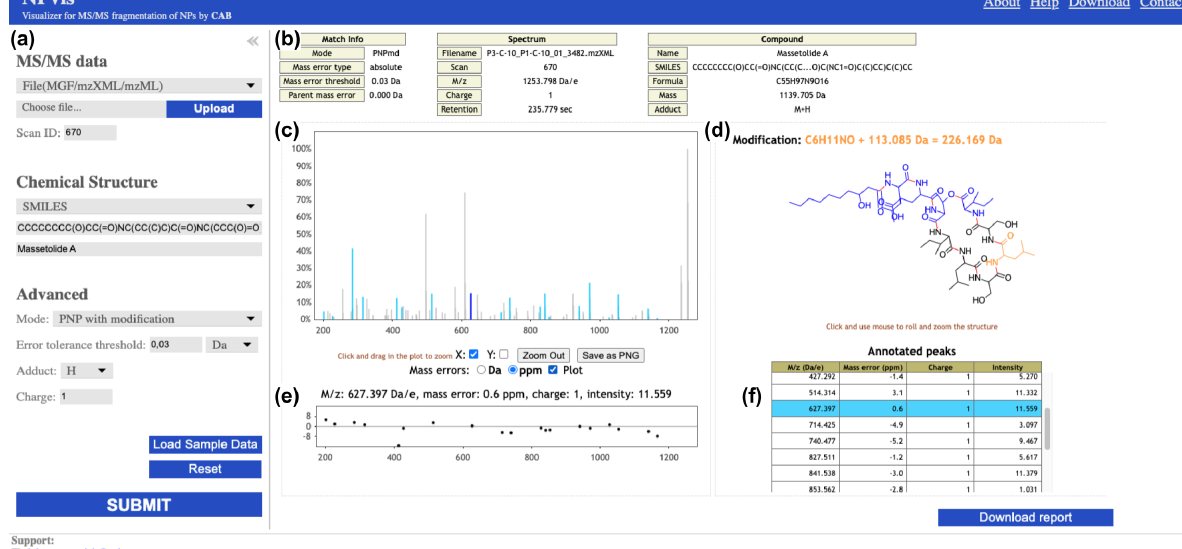
Figure 1. The NPvis web server visualisation of a mass spectrum matching an (unknown) massetolide A variant. ( a ) The foldable control panel allows users to specify the input data and the NPvis settings. ( b ) The metadata panel informs about the provided spectrum and compound and the match parameters. ( c ) The zoomable spectrum panel highlights annotated (sky blue) and not-annotated (grey) MS/MS peaks. ( d ) The zoomable and rotatable compound panel presents the overall chemical structure (black) and the breakable bonds (red) of the compound. In the “PNP with modification” mode, this panel also shows the mass and proposed location of the modification (orange). In this example, the modification is +113.085 Da, which likely corresponds to an insertion of a single leucine or isoleucine residue (monoisotopic mass 113.084 Da). A user may click on an annotated peak in the spectrum panel to see the corresponding structure fragment in the compound panel (both colored blue). ( e ) The hideable mass error plot of absolute (Da) and relative (ppm) discrepancies between the masses of the annotated peaks and the corresponding structure fragments. ( f ) The scrollable list of annotated peaks highlights the selected peak (if any). The ( b – f ) panels are present in the downloadable interactive reports (the bottom-right button), as well as reports generated by command-line